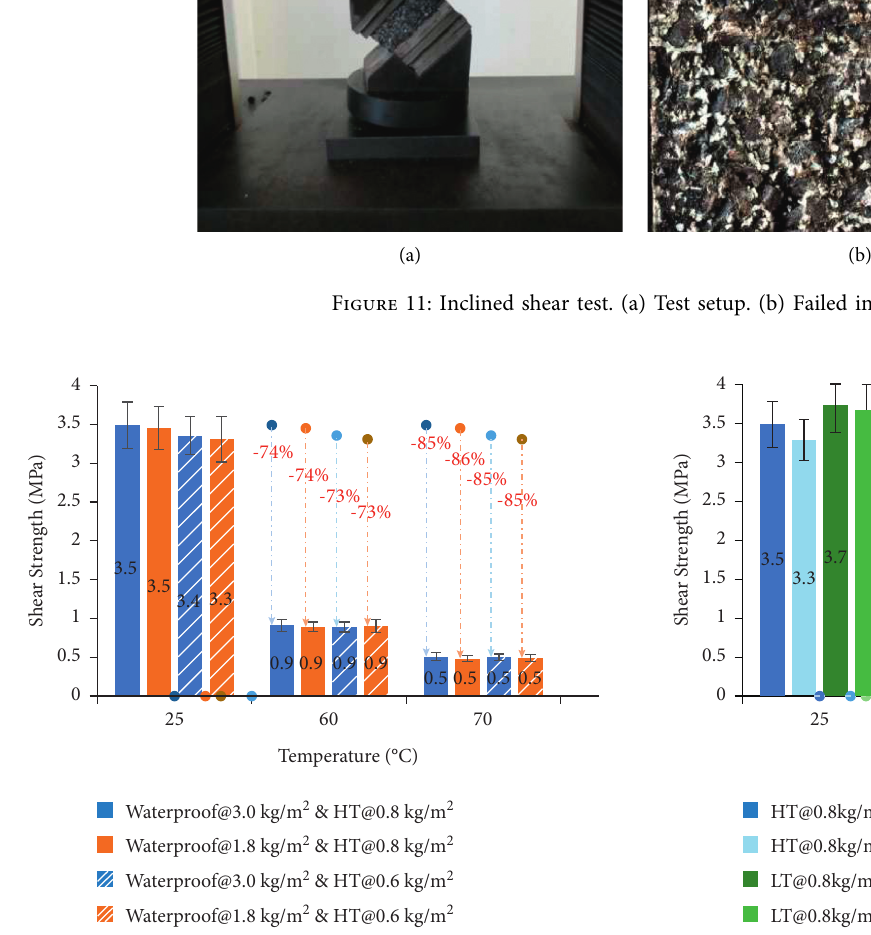
Figure 13: Inclined shear test results in terms of different pellets and compaction